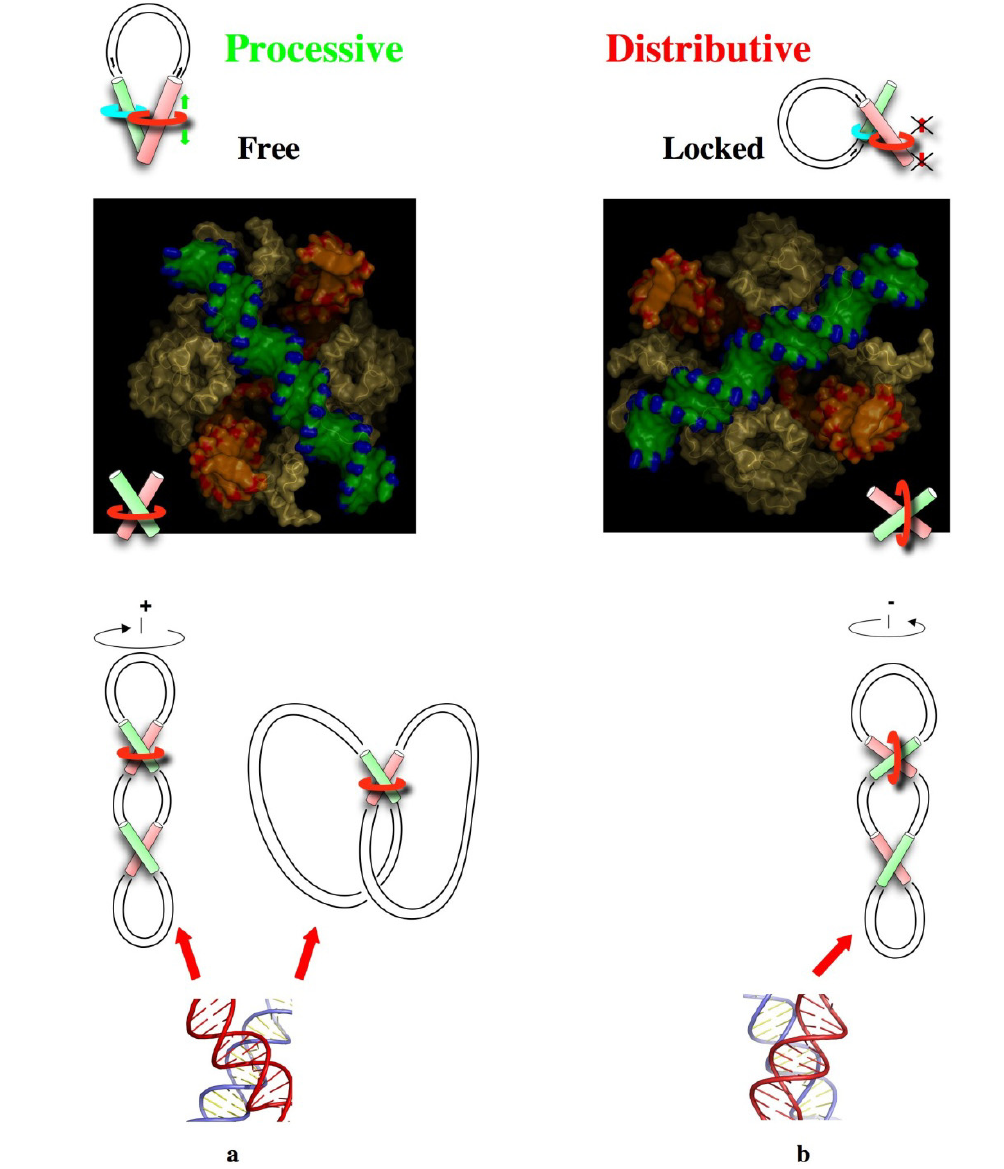
Figure 6. From DNA chirality to the local sensing of global topology. ( a ) Stable right-handed crossovers form spontaneously in relaxed, (+) supercoiled DNA or catenanes. They constitute the natural substrate of type II topoisomerases that clamp them across their large angle (middle). Thus, the topoisomerase ring does not form a topological link with the (+) supercoiled ring. The strand passage reaction generates a free configuration (top) that is consistent with the enzyme processivity; ( b ) Unstable left-handed crossovers are exclusively formed in ( − ) supercoiled DNA. Our model predicts that type II topoisomerases slightly deform and clamp them, across their large angle (middle). This imposes a different orientation in which the enzyme ring and the ( − ) supercoiled DNA ring are topologically linked. The strand passage reaction generates a locked configuration (top) that explains the distributive behaviour of the enzyme. The gate DNA-segment (G) and transported DNA-segment (T) are represented in red and green,